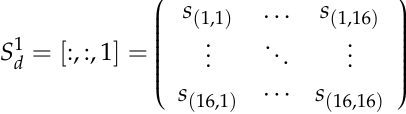
Figure 4. The structure of the data set.